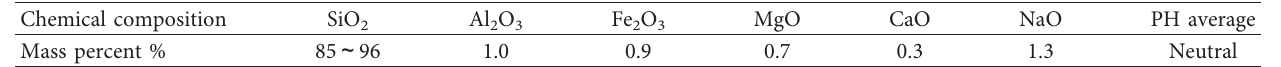
Table 6: Chemical composition of silica fume.